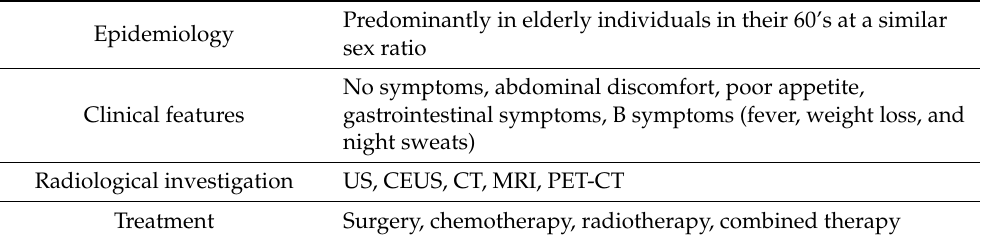
Table 2. Epidemiology, clinical features, radiological investigation, and treatment of hepatic extran- odal marginal zone lymphoma of